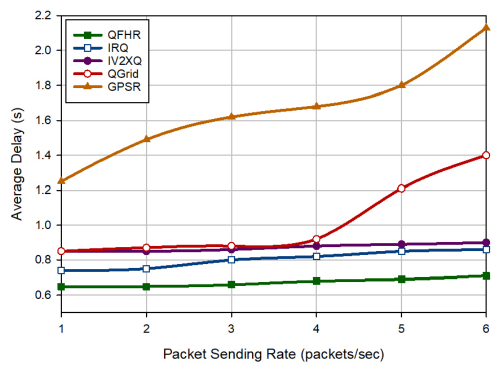
Figure 12. Average delay in different approaches according to PSR.